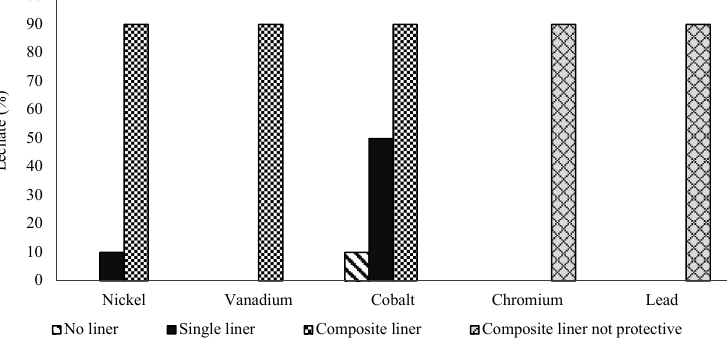
Fig. 2: Liner scenarios under different leachate concentrations